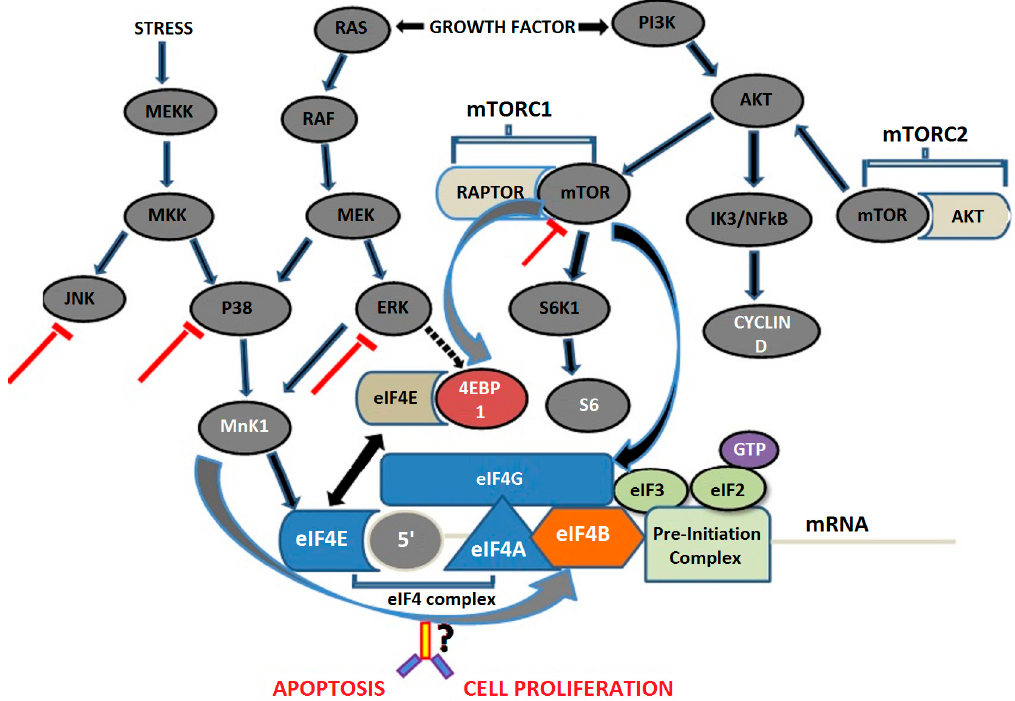
Figure 1. Proposed schematic diagram showing combined inhibition of MAPK and mTOR pathways.